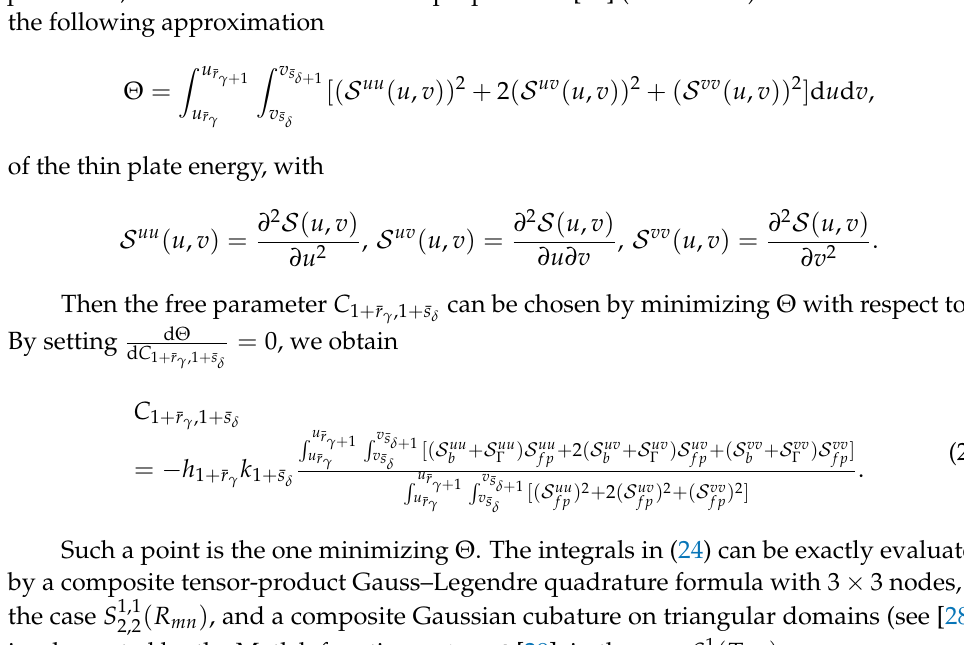
Figure 11. ( a ) Tensor product and ( b ) triangulated surfaces with U = V = the two free control points C 1,1 = C 1,3 = ( 5,5,5 ) , being the barrier at knots v 2